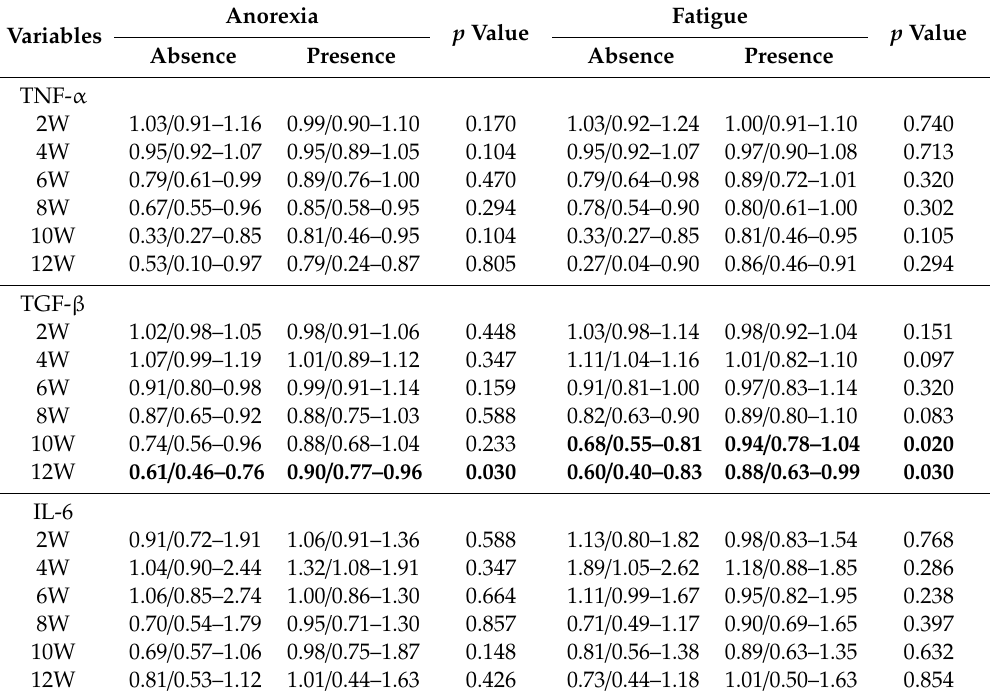
Table 2. Post- / pretreatment ratio of inflammation-related markers and anorexia or fatigue. Variables